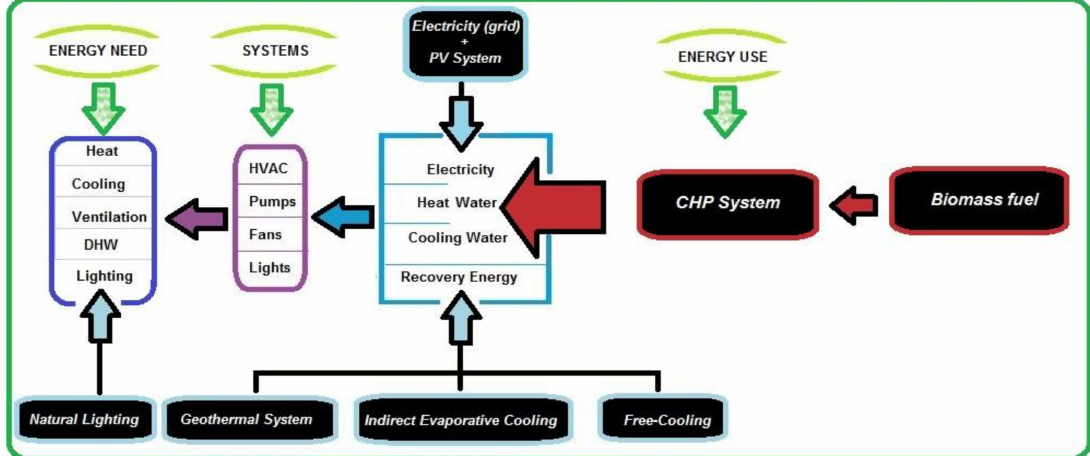
Figure 7. Energy Systems flow chart of the